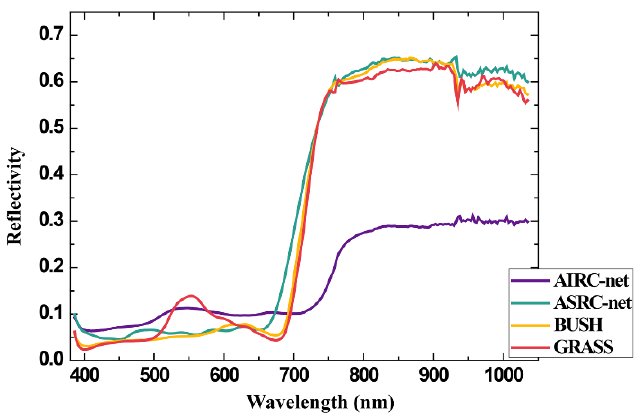
Figure 3. The spectra of different targets and vegetation.